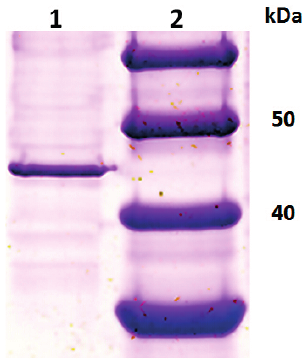
Figure 1. SDS-PAGE analysis of purified PGC3 from FOC4. Lane 1: purified PGC3; Lane 2: protein